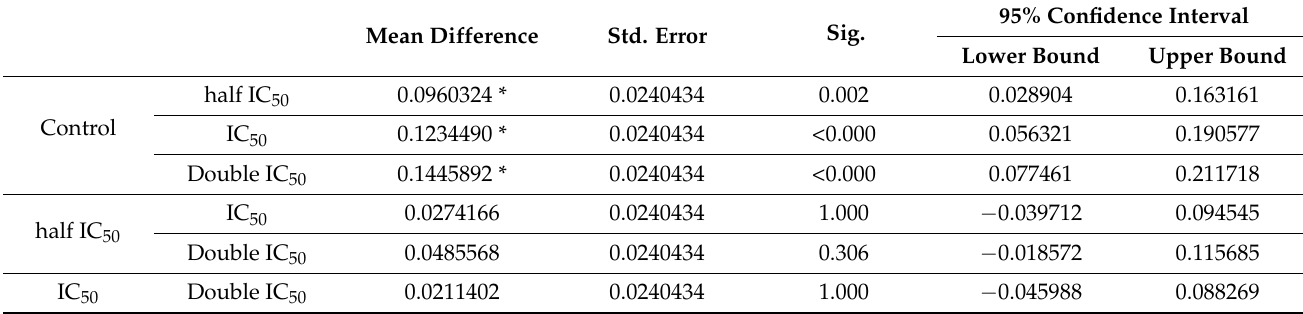
Table 8. Post hoc comparison test (Bonferroni) for comparison of mean difference of NAF values for different propolis concentrations and control cells (24 h after